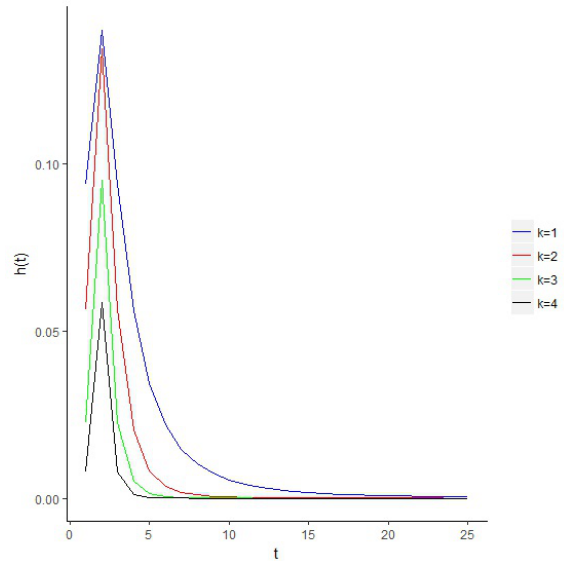
Figure 1 – Hazard rate for c = 2 and α =